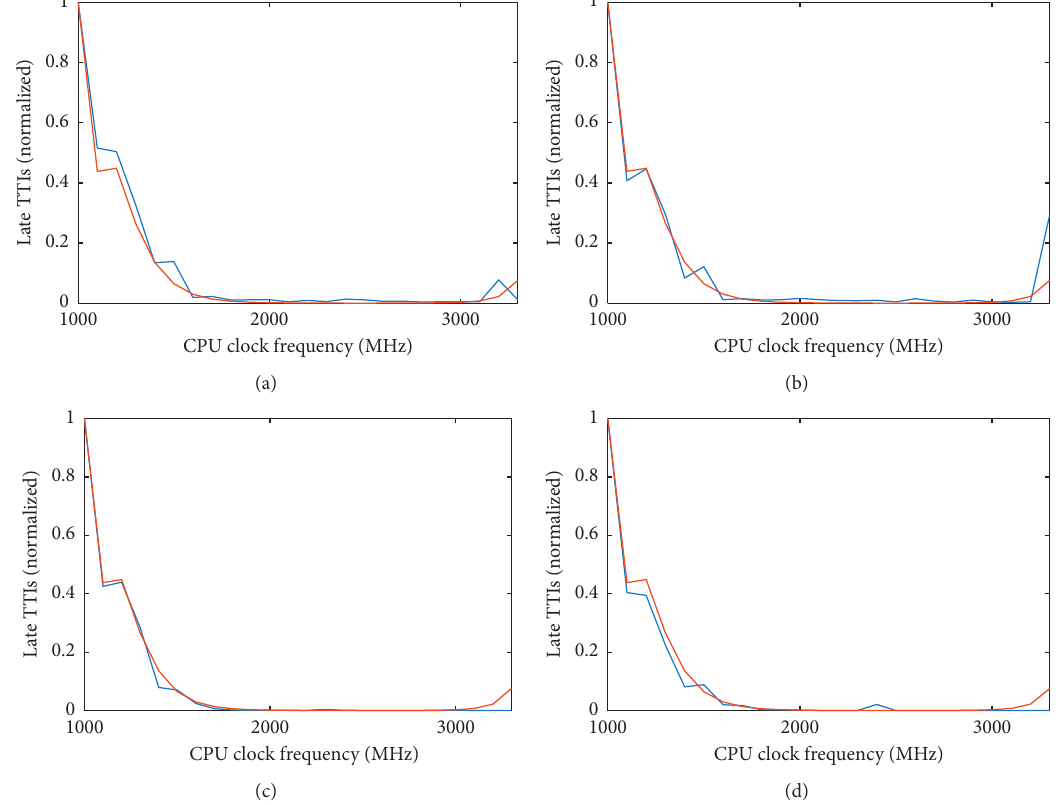
with seven parameters f . (a) 5MHz bandwidth. (b) 10MHz 0 m